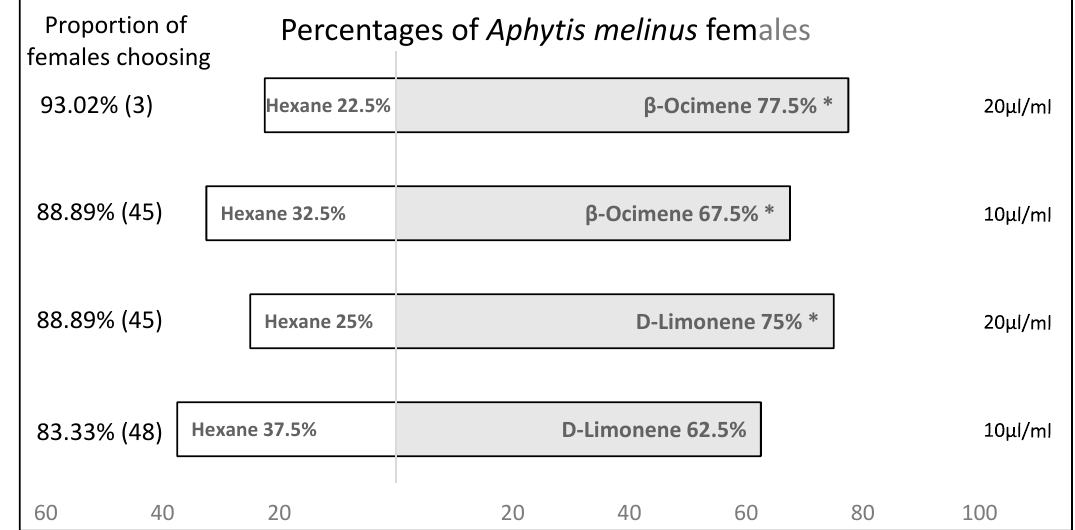
Figure 3. Attraction of female Aphytis melinus to VOCs differentially emitted by A. aurantti -infested citrus fruits. Choice bioassays were conducted in a Y-tube olfactometer presenting one of the two dosage levels (10 and 20 μ L/mL) of citrus fruits VOCs vs. hexane. Asterisks indicate significant differences between numbers of VOC and control choices ( χ 2 test with Yates’ correction, p < 0.05). To the left of the bars is the proportion of females that made a choice for one of the two odours, as well as the total number of females that were tested.